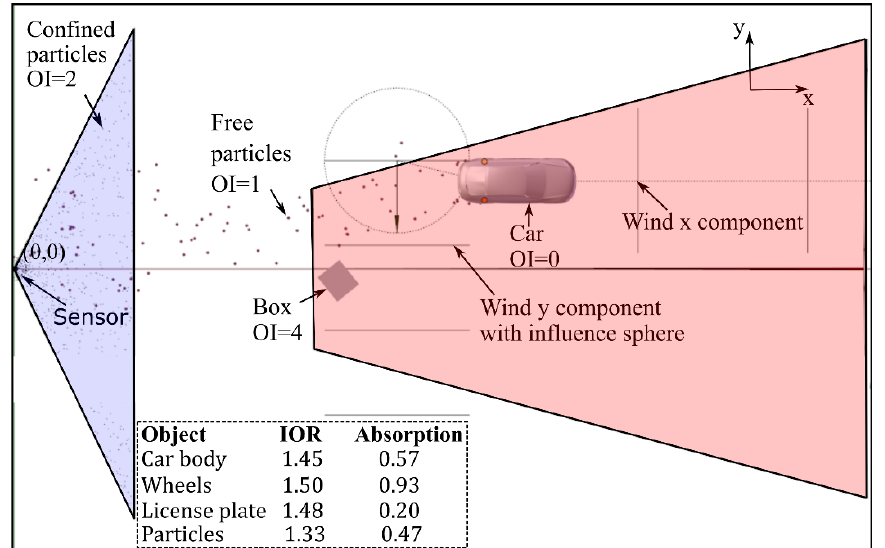
Figure 4. Simulation setup. The object index (OI) is a parameter used by the render to create a separate mask for the object to add composition effects [34] and makes it is possible to identify which object caused which detections. Notice the correspondence with Figure 2. The ROI is marked in red. The region in violet corresponds to a volume in which confined particles are uniformly distributed to simulate the detections caused by rain. The index of refraction (IOR) and absorption used for the material of each object is shown in the dashed line region [10].